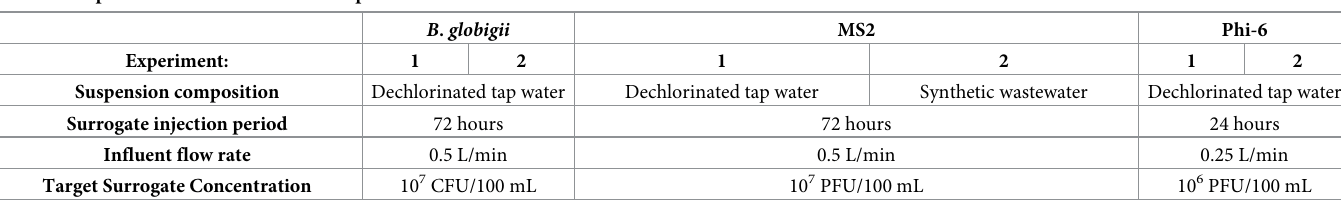
Table 1. Experimental conditions for all